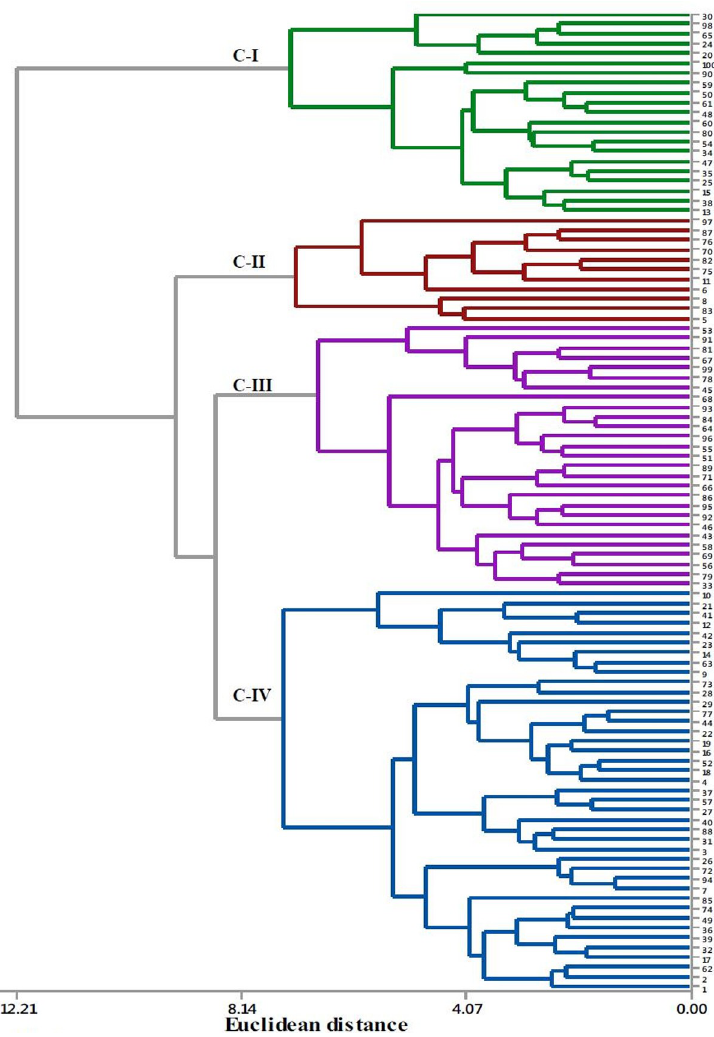
Fig 2. Cluster analysis showing the relationship among cocoyam accessions based on quantitative traits. The numbers stand for the serial numbers of the accession code. The accessions 1–14, 15–26, 27–54, 55–82 and 83–100 were from Bench-maji, Kefa, Dawuro, Wolaita and Gamo-Gofa zones, respectively.